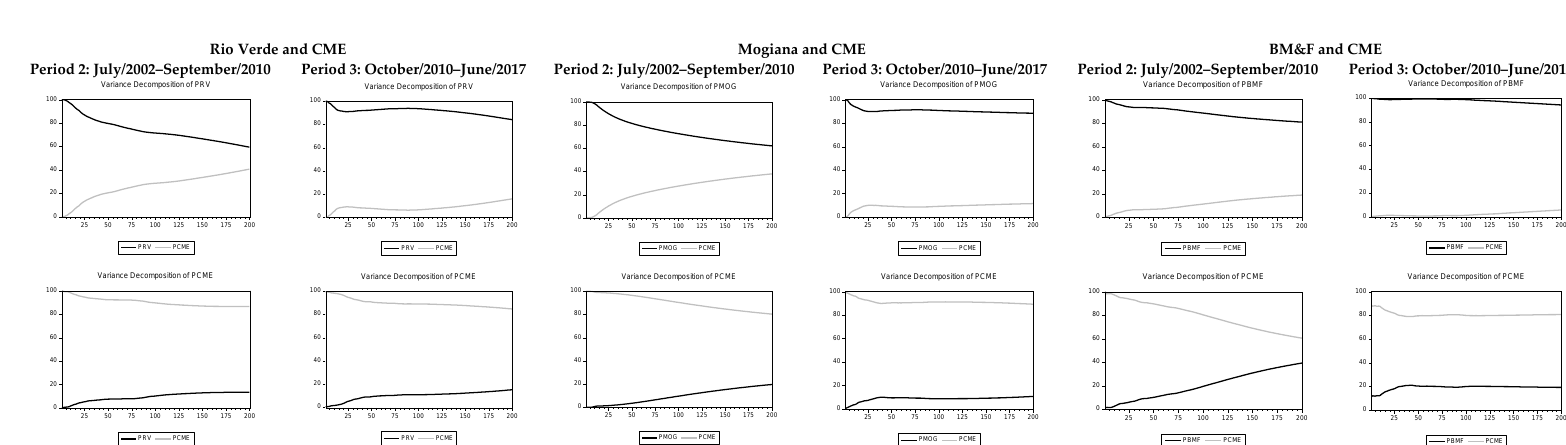
Figure A4. Forecast error variance decomposition for spot and futures prices in Brazil.